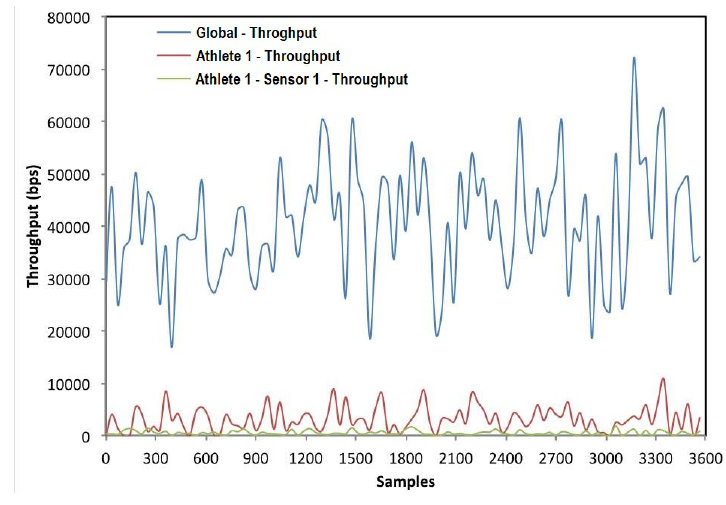
Figure 9. Throughput in bits/s. Table 3. Comparison between other sports monitoring systems. HRL: heart rate laps, Acc.: acceleration, AirE: air exhalation, T: